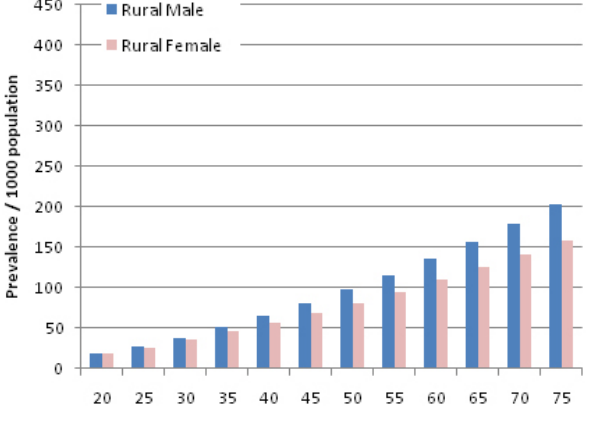
Figure 14. Male and female prevalence of type 2 diabetes in Southern Asia based on information from rural